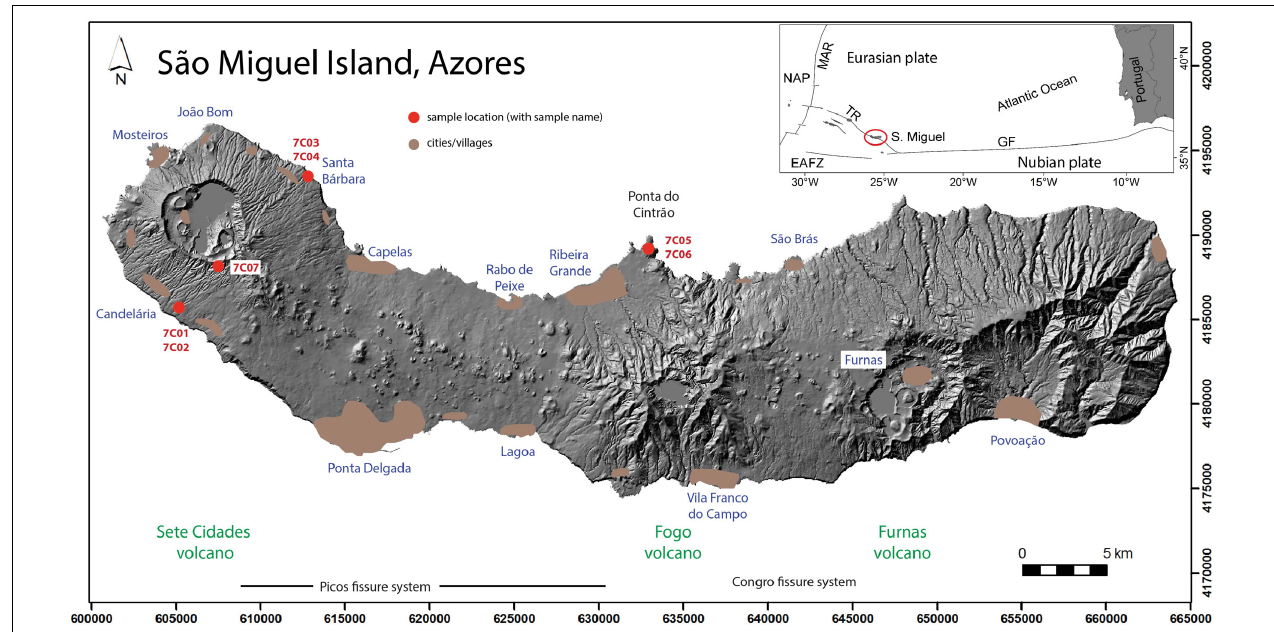
FIGURE 1 | Map of São Miguel Island showing the location of the three central volcanoes (Sete Cidades, Fogo, and Furnas), the main inhabited areas (cities and villages) and collected samples. Samples 7C01 and 7C02 collected near Candelária (outcrop A) on the southern slope of Sete Cidades volcano (7C), samples 7C03 and 7C04 near Santa Bárbara (outcrop B) on the NE slope, samples 7C05 and 7C06 at a distal location on the Ponta do Cintrão peninsula (outcrop C) and sample 7C07 collected close to 7C caldera rim (outcrop D). Inset illustrates the geographic position of São Miguel (Azores archipelago) in the Atlantic Ocean and the main structural features (NAP, North American plate; MAR, Mid-Atlantic Ridge; TR, Terceira Rift; EAFZ, East Azores Fracture Zone; GF, GLORIA